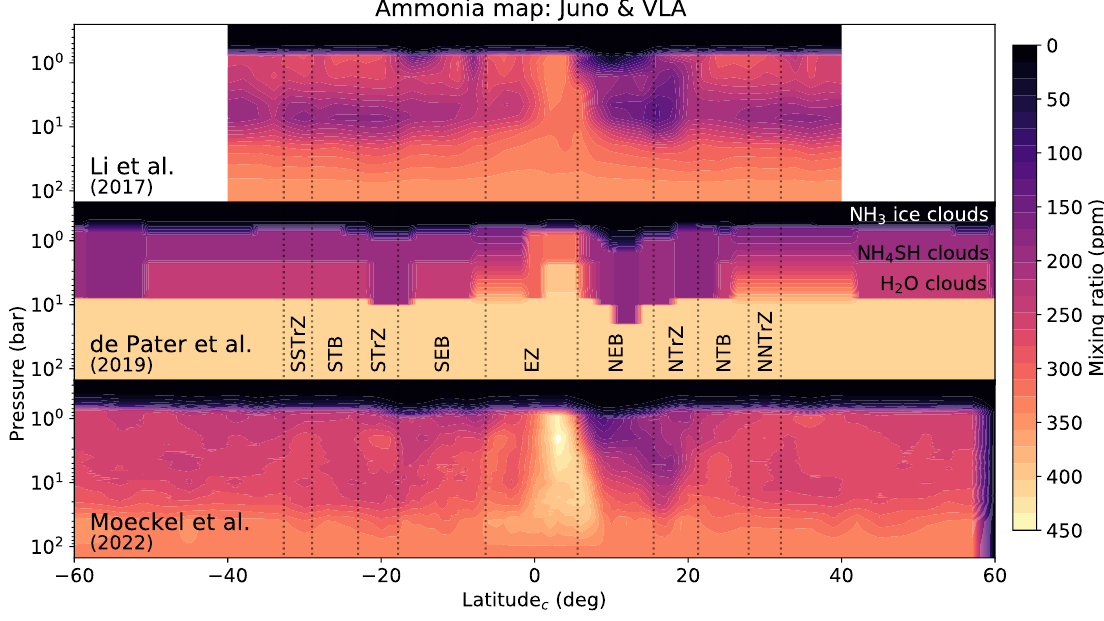
Figure 10. Top : Ammonia abundance map for Jupiter as derived from Juno ’s PJ1 nadir brightness temperatures by Li et al. [89]. Middle : Ammonia abundance map as derived from VLA maps obtained throughout 2014 at 1–10 cm. Note that these observations do not probe down below the ∼ 10 bar level, except in “dry” areas such as the NEB [13]. Bottom : Ammonia abundance map as derived from the combined VLA 1–10 cm brightness temperature and the average of Juno ’s PJ1-12 orbits, combining brightness temperature and limb-darkening coefficient [33]. All three maps show familiar features, such as the column of enriched ammonia in the EZ and the depletion of ammonia in NEB, while the Juno data reveal the depths to which the atmosphere is depleted. It also shows an undulating pattern in the pressure level near 20–30 bar indicative of a circulation model of stacked cells. (Adapted from